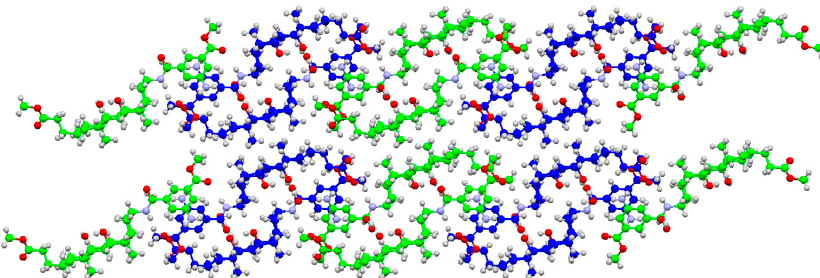
Figure 4. View of crystal packing of compound 24 along the b axis. For clarity, the carbon atoms of the two molecules of the asymmetric unit are drawn in different colors.